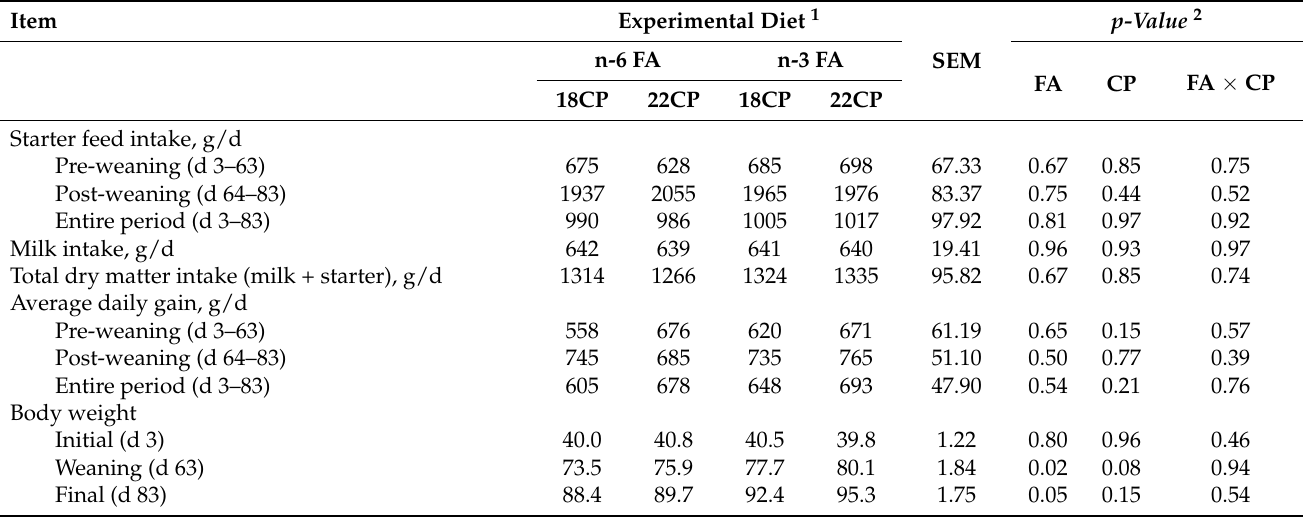
Table 2. Least square means for starter intake, average daily gain, and feed efficiency in dairy